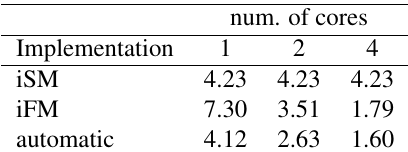
Table 3. Average composition time [secs] with forced and auto- matic selection of the implementation. num. of